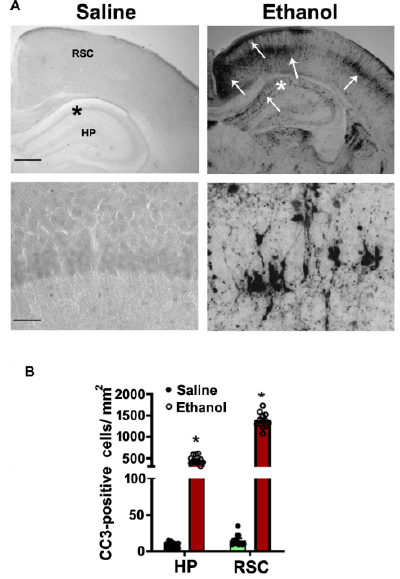
Figure 1. Enhanced CC3-positive cells in the P7 mouse HPand NC brain regions in response to high-dose ethanol exposure. The free-floating coronal brain sections (HP, and RSC (retrosplenial cortex)) were obtained after saline and 8 h ethanol-exposed mice and sections were subjected to IHC analysis with anti-rabbit-CC3 ( A ). The arrows indicate the CC3-positive neurons in the HP and RSC. Scale bars = 200 µ m. The hippocampal region was enlarged to show the CC3-positive cells (*). CC3-positive cells were counted in the HP and RSC brain regions ( B ). Error bars, SEM (* p < 0.05 vs. the saline group, n = 6 pups/group).